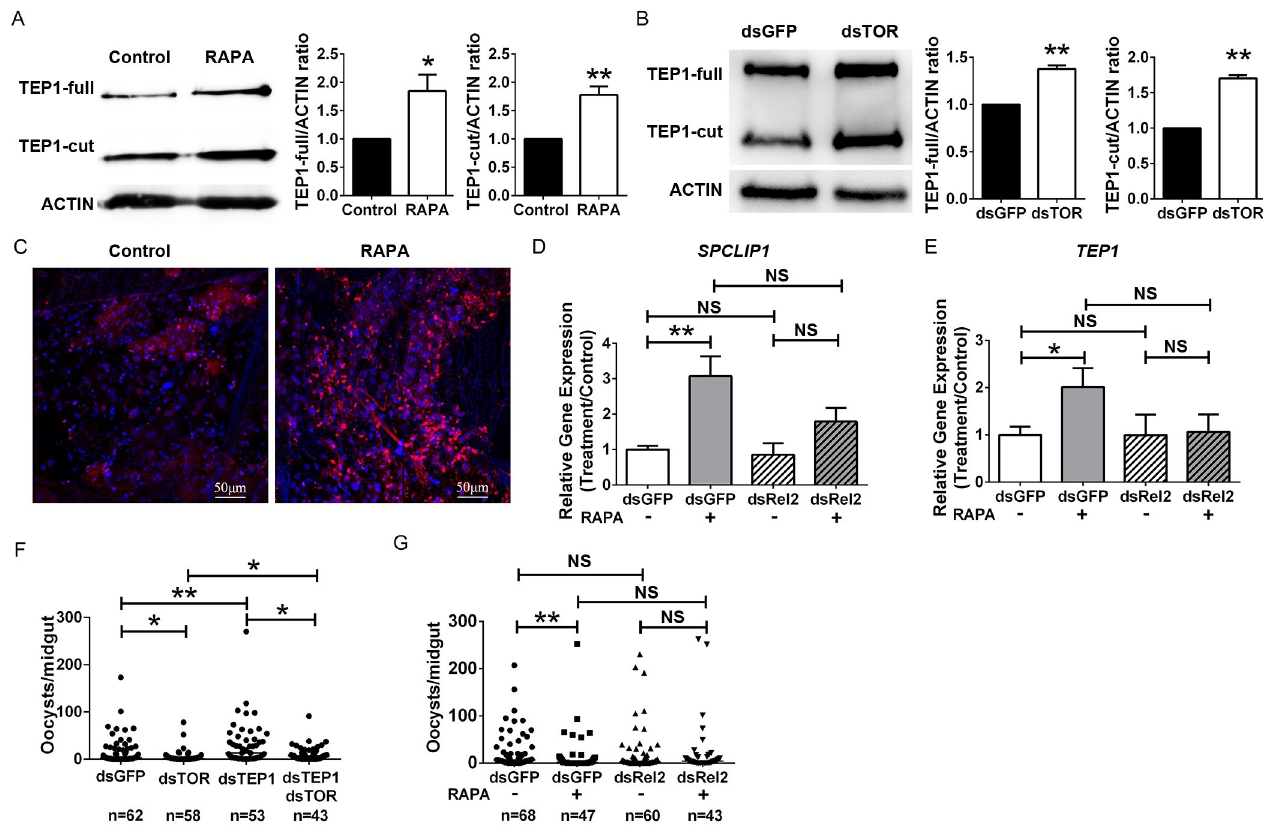
Fig 5. The REL2 is essential in rapamycin mediated increasing resistance to Plasmodium infection. Western blot analysis of TEP1 in fat bodies of rapamycin-treated (A) and dsRNA- treated (B) mosquitoes 24 hpi. The blot was probed with the anti-TEP1 polyclonal antibody. An . stephensi ACTIN was used as the loading control. The bar chart represents relative quantification of signal intensity from at least two independent replicates determined by ImageJ software. Error bars indicate standard errors (n � 2). (C) Whole-mount staining of TEP1 (red) in fat bodies of rapamycin-treated (RAPA) and control (Control) mosquitoes 24 hpi. Nuclei were stained with DAPI (blue). Images are representative of three independent experiments. Scale bars = 50 μ m. Influence of REL2 on gene expression of SPCLIP (D), and TEP1 (E) in rapamycin-treated mosquitoes. Expression of target genes was normalized to the reference gene S7 . Relative gene expression in treated mosquitoes was normalized to that of dsGFP controls. Error bars indicate standard errors (n = 9). Results from one of three independent experiments are shown. (F) Influence of TEP1 on parasite infection. Data were pooled from three independent experiments. (G) Influence of REL2 on vector competence in rapamycin-treated mosquitoes. Data were pooled from at least two independent experiments. Significance was determined by Student’s t -test in (A), (B), (D) and (E), and by a Mann-Whitney test in (F, G). � P < 0.05, �� P < 0.01; NS, not significant.